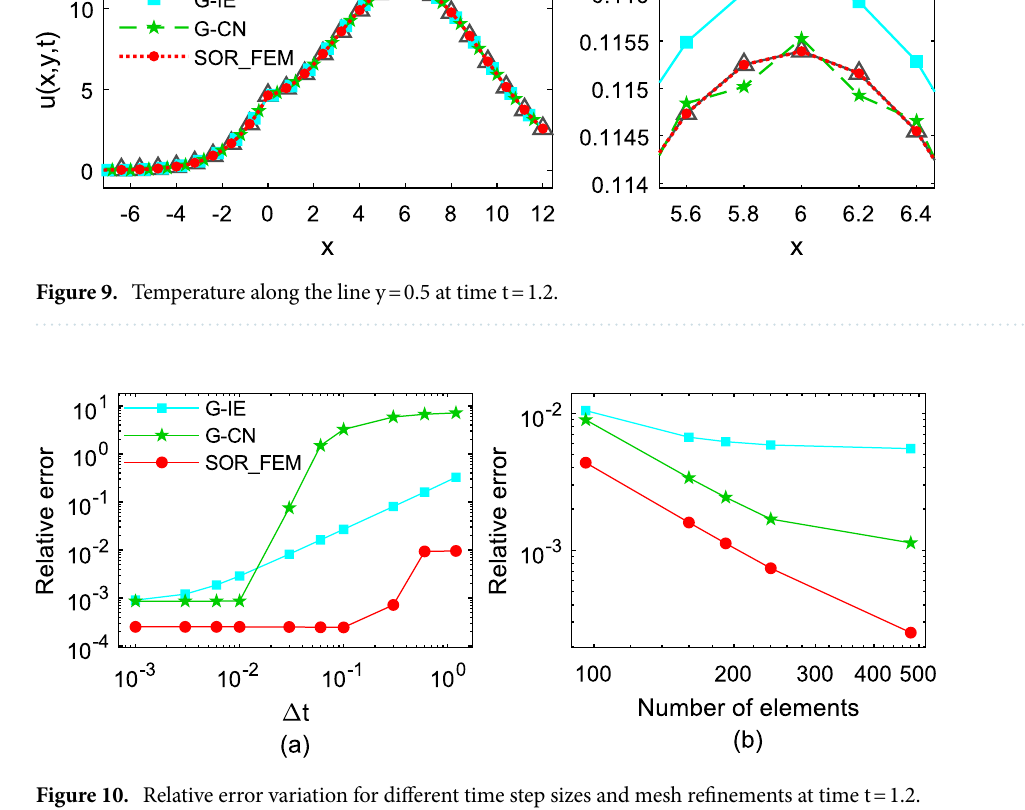
Figure 10. Relative error variation for different time step sizes and mesh refinements at time t = 1.2.